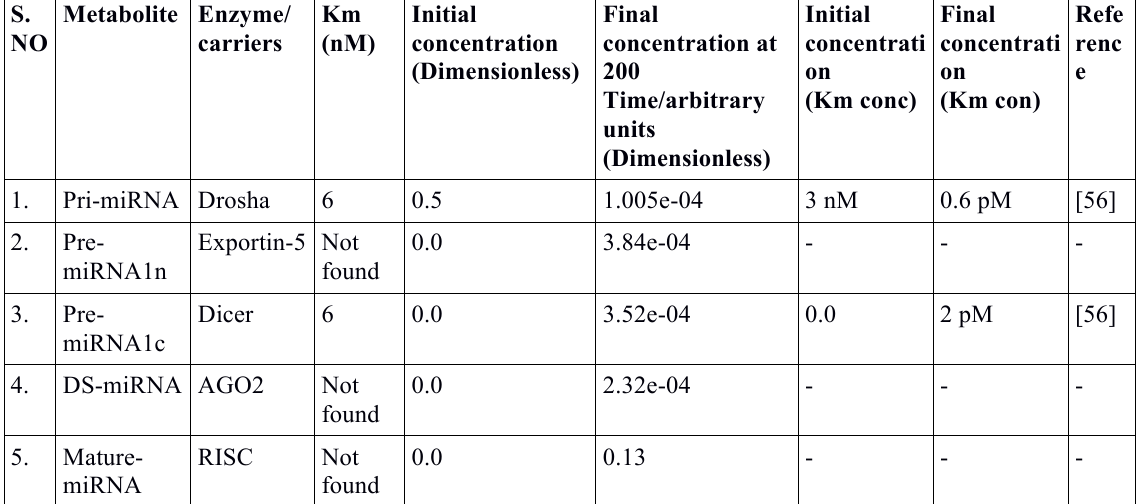
Table 2: Metabolite